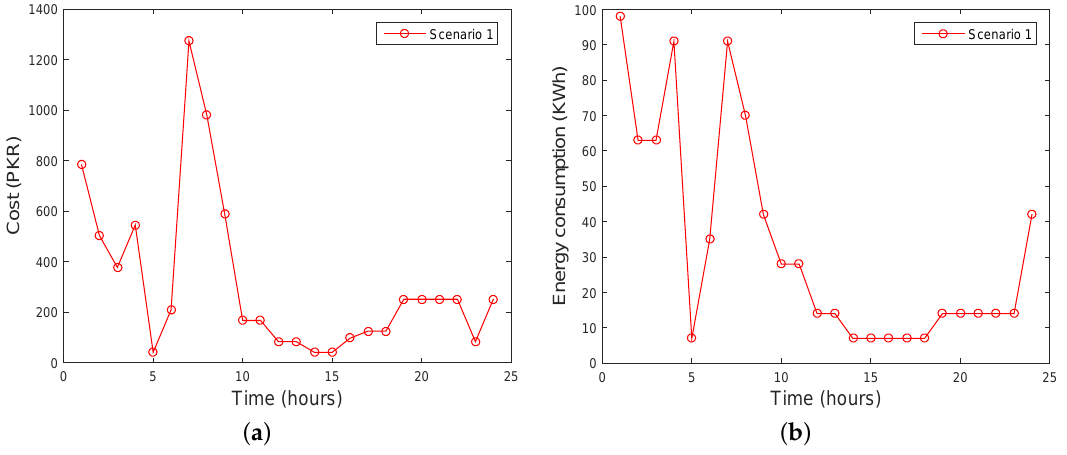
Figure 5. Baseline: without EMS (Scenario 1). ( a ) Cost profile (Scenario 1); ( b ) load profile (Scenario 1).